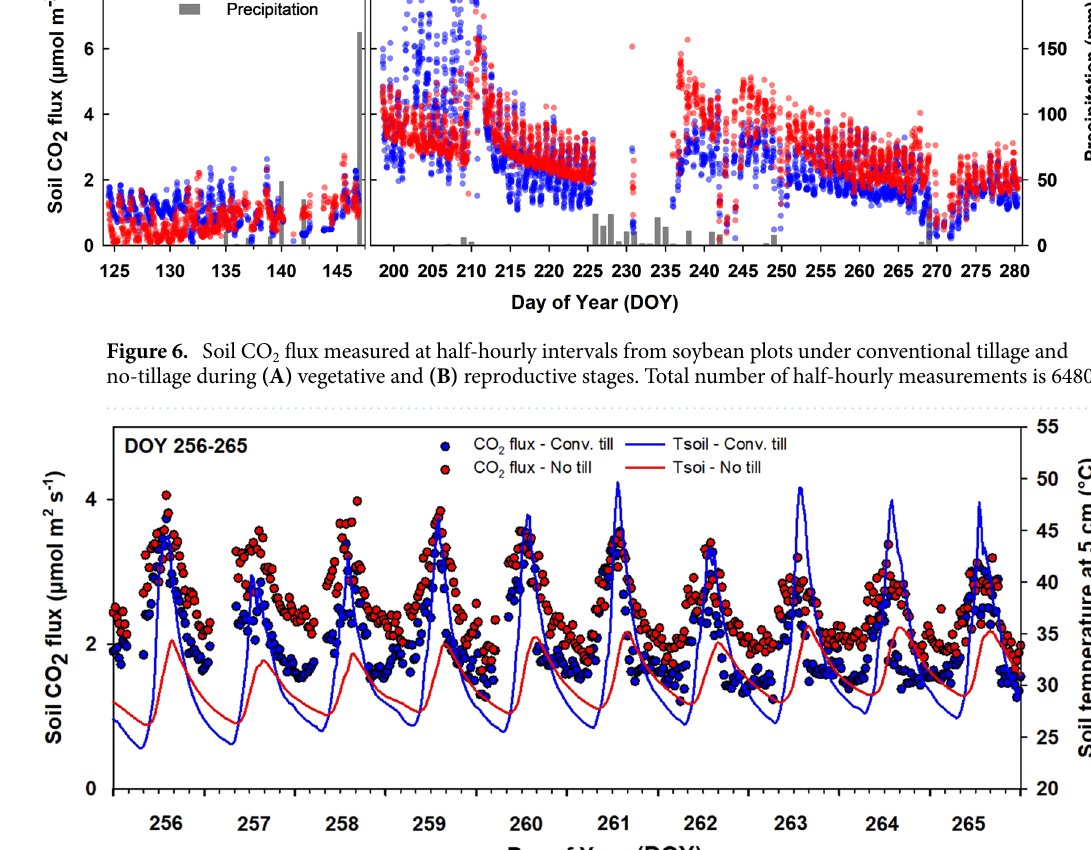
Figure 7. Diurnal soil CO 2 flux and soil temperature measured at 5 cm depth in conventional tillage and no-tillage soybean during DOY